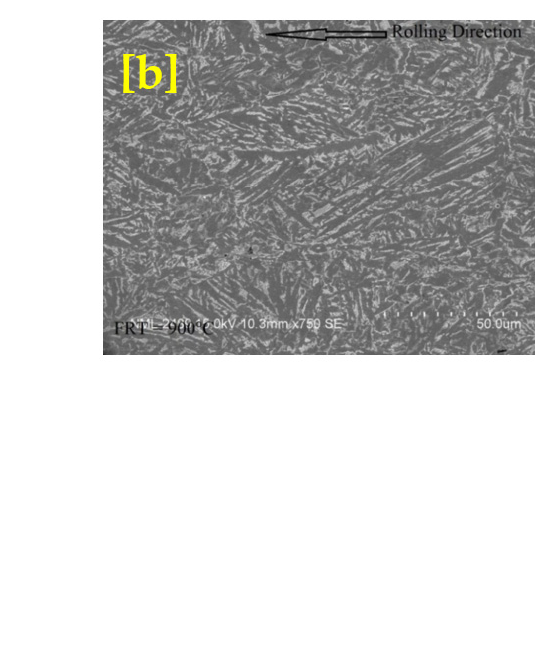
Figure 8. Optical micrographs of rolled niobium microalloyed steel in which finishing rolling temperature ( a ) 800; ( b ) 900; ( c ) 1000 °C.